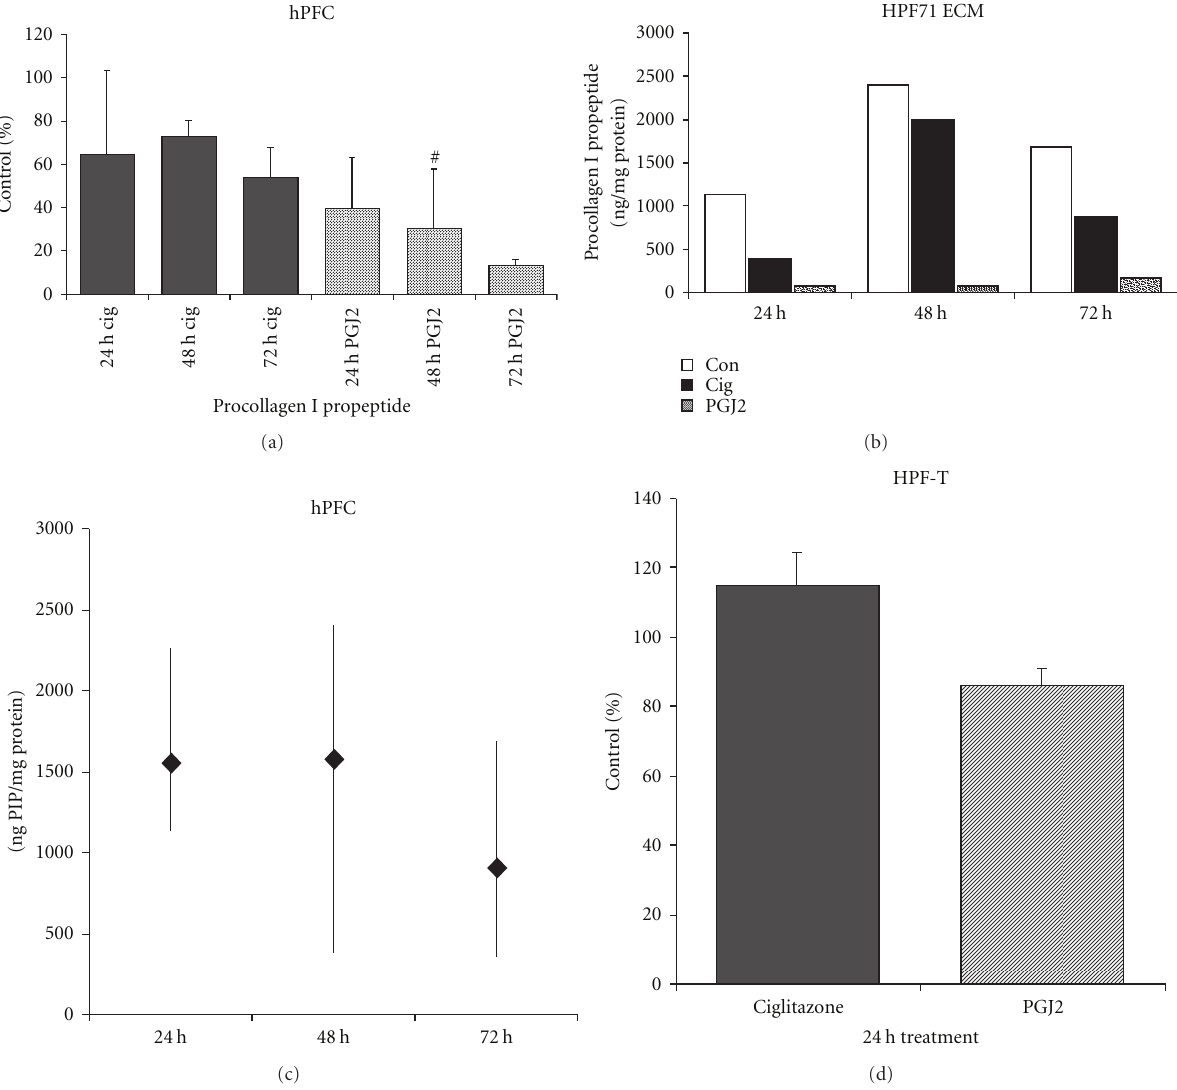
Figure 6: Analysis of collagen synthesis. (a) Procollagen I propeptide (PIP) secretion of hPFC presented as percent of control after 24, 48, and 72 h of ciglitazone (3.3 μ M) and PGJ2 (5.0 μ M) treatment. The reduction of PIP content in culture supernatants was significant,